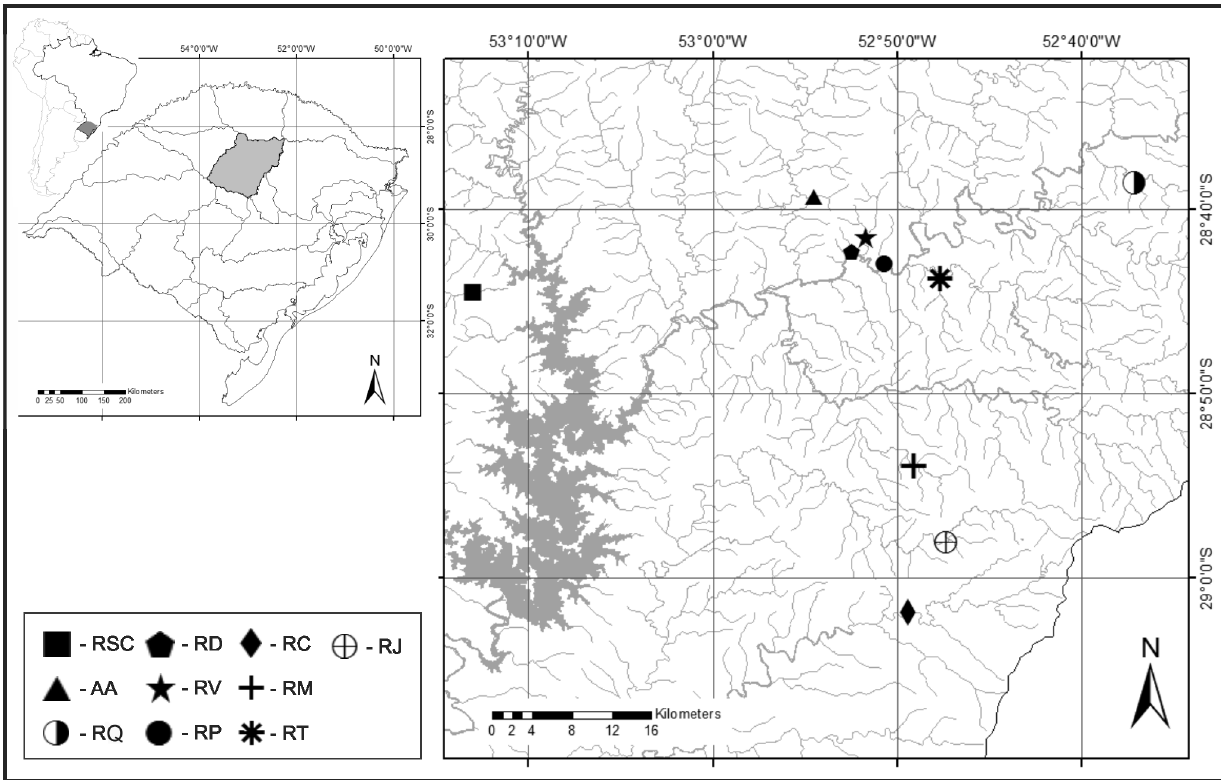
Figure 1. Sampling streams. Sampling streams in the Alto Jacuı´ sub-basin, state of Rio Grande do Sul, Brazil. For stream code see Material and Methods.